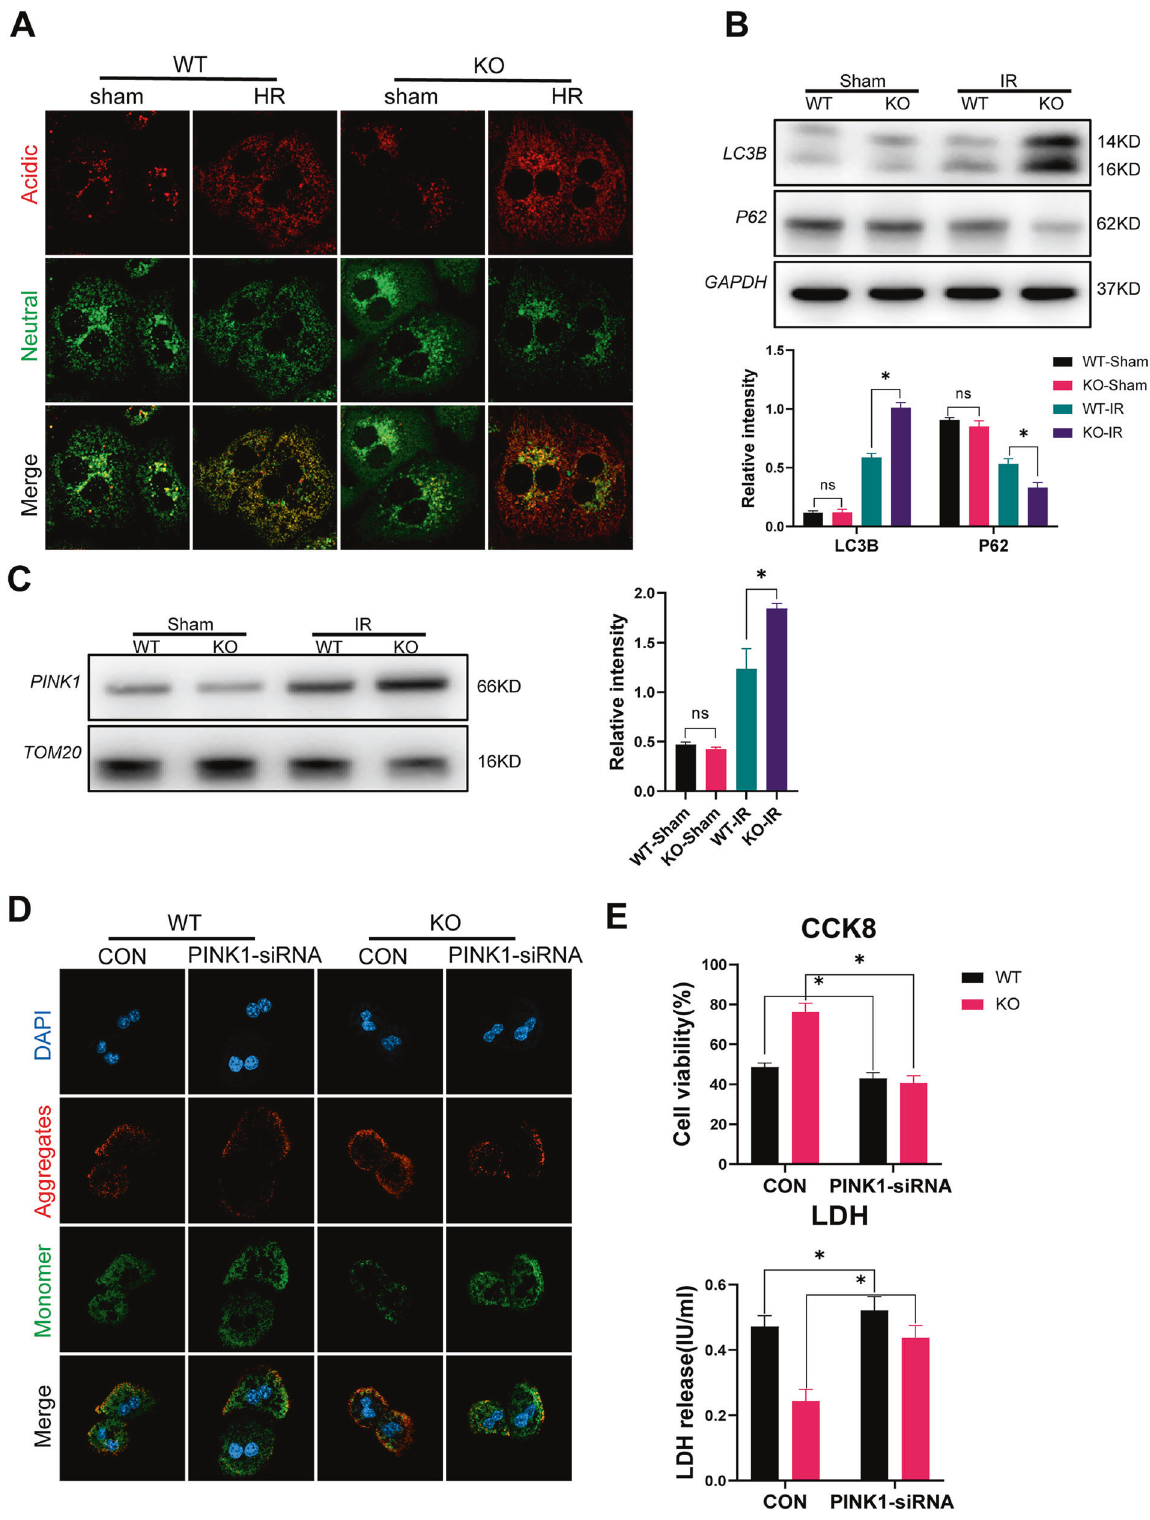
Fig. 5 MLKL depletion promoted PINK1-mediated mitophagy to reduce oxidative DNA damage in hepatocytes. Primary hepatocytes were isolated from WT and MLKL KO mice and subjected to H/R model as described in the section of methods. A Representative confocal microscopy images of mt-mKeima-expressing primary hepatocytes, analyzed the pixel area in the red channel (acidic) and normalized to the signal in the green channel (neutral). B Western blot analysis of LC3B, P62 and GAPDH in primary hepatocytes. C Western blot analysis the mitochondrial protein of PINK1 and TOM20 in primary hepatocytes. Primary hepatocytes isolated from WT and KO mice were transfected with PINK1-siRNA or CON-siRNA (control) and subjected to H/R model. D Detection of MMP by JC-10 staining. J-aggregates (Red), J-monomer (Green). E Hepatocyte viability and injury/cell death were evaluated by CCK-8 assay and lactate dehydrogenase assay ( n = 5). All results represent at least two independent experiments. Values were expressed as mean ± SD. * p < 0.05. Cell Death Discovery (2023)